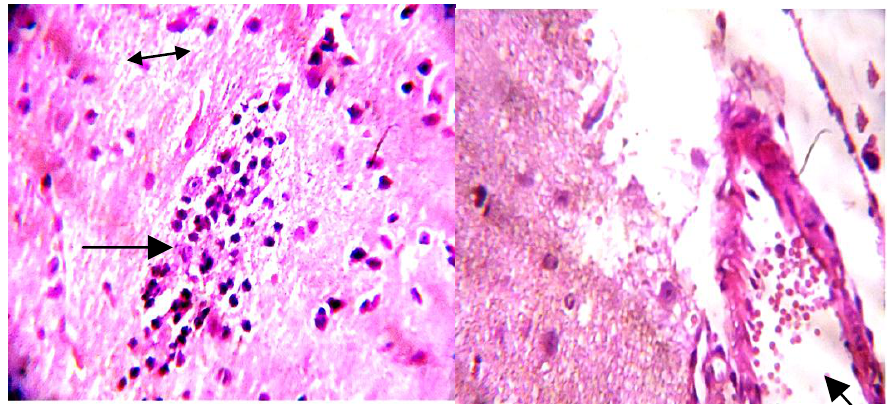
Fig:1 , Histopathological section Brain control Fig:2 , Histopathological section Brain control with normal structure of (H&E stain. 40X) show normal structure of perkangi